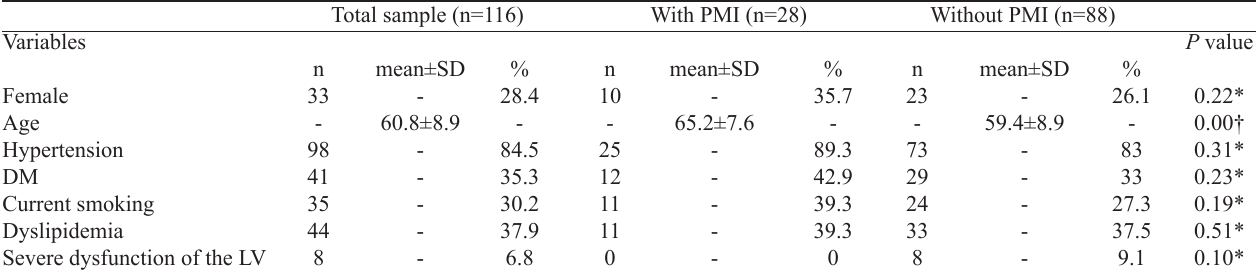
Table 1. Profile of the sample and epidemiological characteristics.